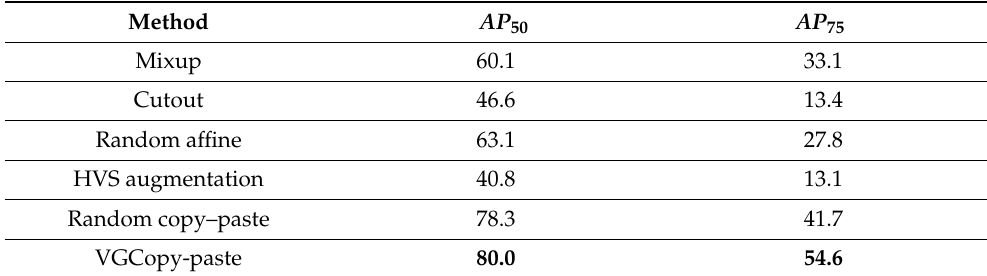
Table 5. Performance of different data augmentation methods in the abnormal road manhole cover detection